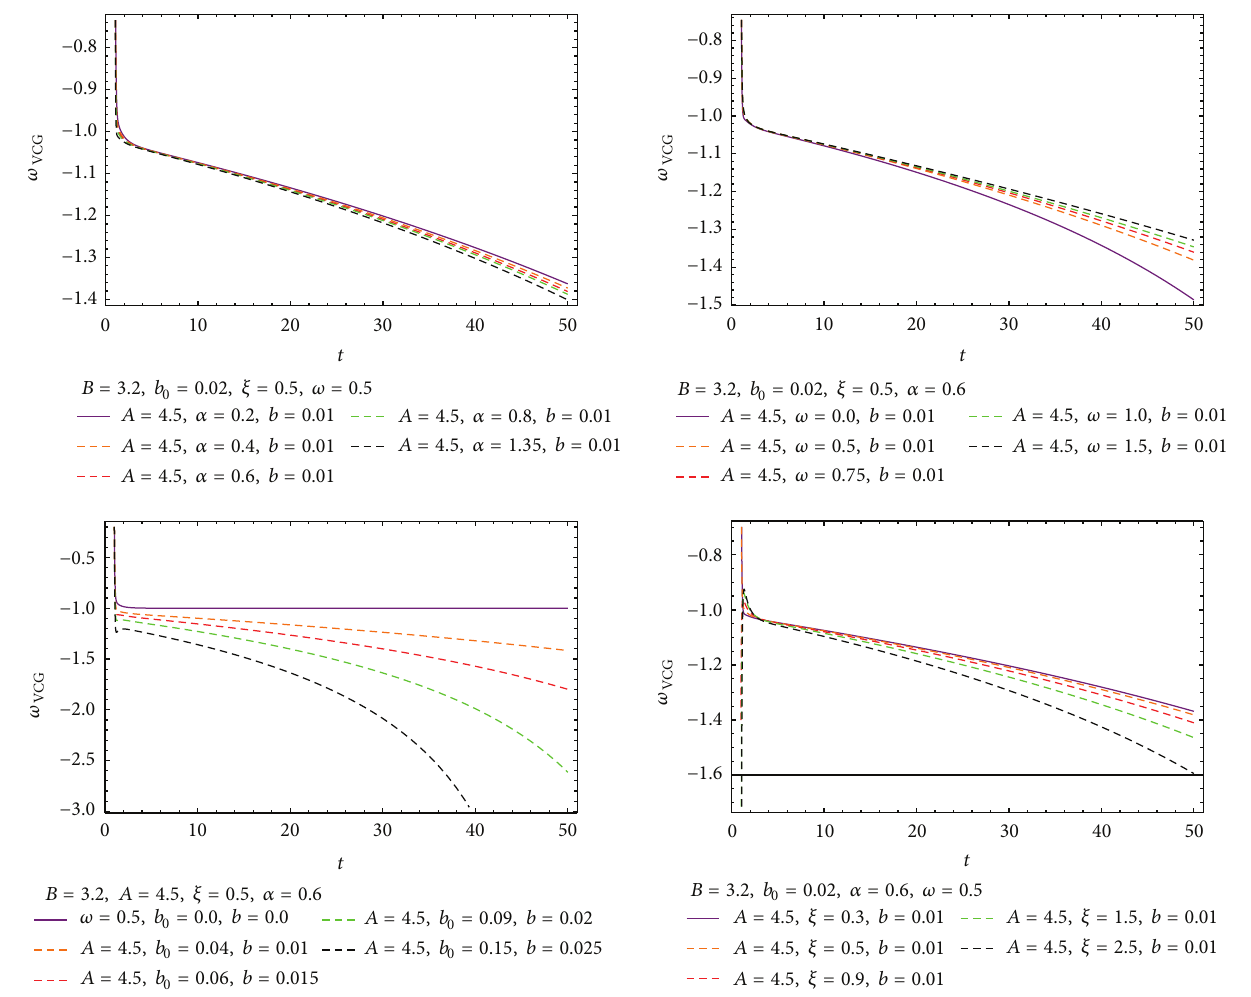
against 𝑡 for interacting barotropic fluid and viscous Chaplygin VCG